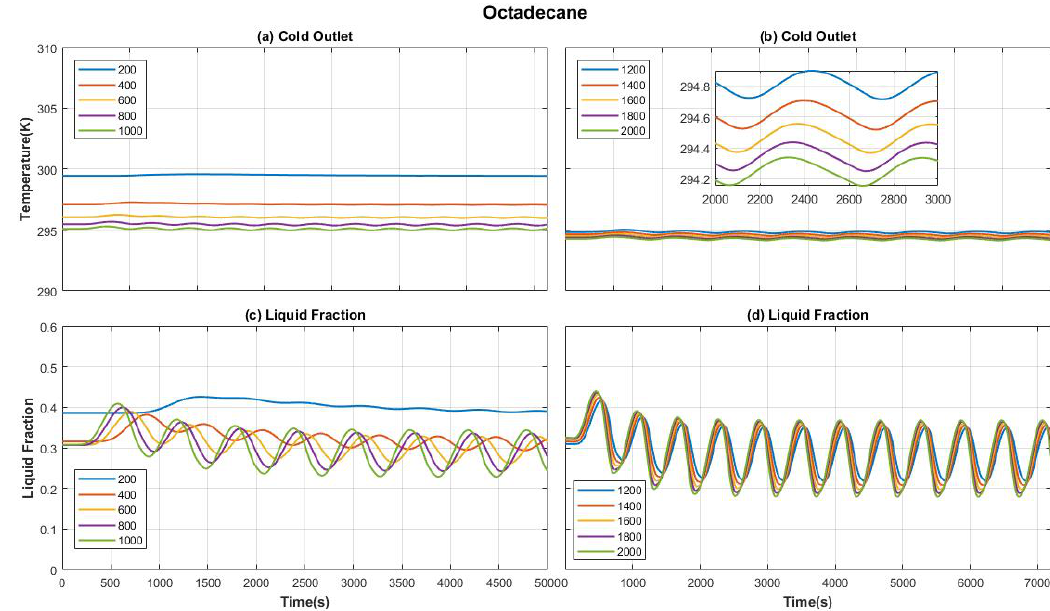
Figure 8. Cold outlet temperature and liquid fraction for octadecane ( T s = 300.65 K, T l = 301.65 K) at Reynolds from 200 to 2000. Reynolds 200–1000 on the left ( a , c ) and 1200–2000 on the right ( b , d ). The octadecane remains in a partial phased changed state during the full oscillation cycle. This is reflected in the shape of the cold outlet variations which have a stretched out shape on both the positive and negative variation of the cycle unlike with the eicosane which only shows the structure on the positive